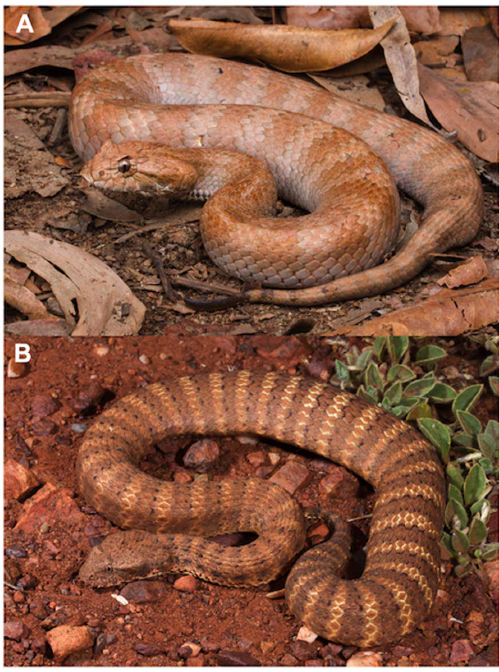
Figure 1. Photographs showing the diversity of body forms within Acanthophis . (A) tropical death adder ( Acanthophis praelongus ) from Iron Range National Park, Queensland, and (B) a desert death adder ( A. wellsi ) from Karatha, Western Australia. Photographs by Stephen Zozaya, with permission.